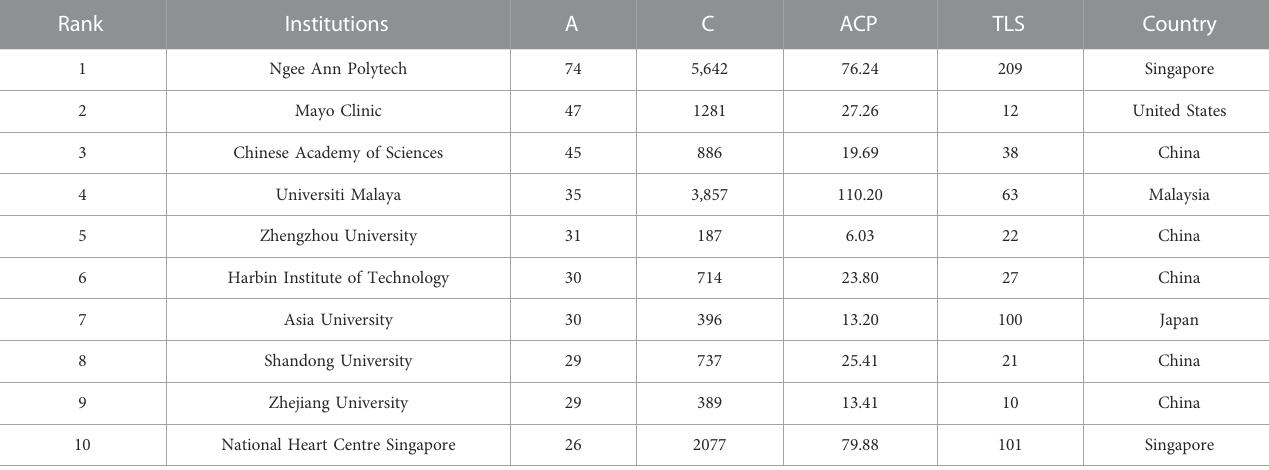
TABLE 2 Top 10 productive institutions concerning the research of AI on ECG. Rank